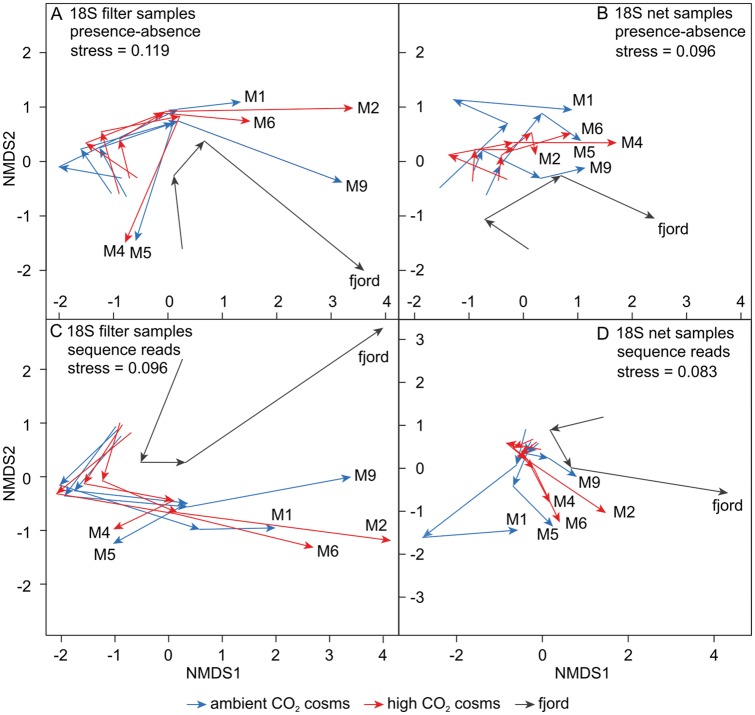
nMDS of OTU compositions over the experimental period.Analysis of (A) filter samples, based on the 18S presence-absence-transformed data, (B) net samples, based on the 18S presence-absence-transformed data, (C) filter samples, based on the 18S sequence read data and (D) net samples, based on the 18S sequence read data. Mesocosms are indicated by their number (M1, M2, M4, M5, M6, M9). In each subplot, the beginning of the first arrow for each mesocosm represents the first time point (t17). The second (t41), third (t65) and fourth (t91) time points are represented by the subsequent arrowheads, respectively. Ambient and high CO2 mesocosms are indicated by blue and red arrows, respectively. The fjord is indicated by grey arrows.